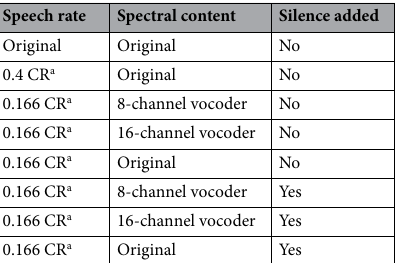
Table 1. The different conditions assessed during the experiment. Each condition was assessed with a single list consisting of ten sentences. a Condition was assessed both in the test and retest assessment.